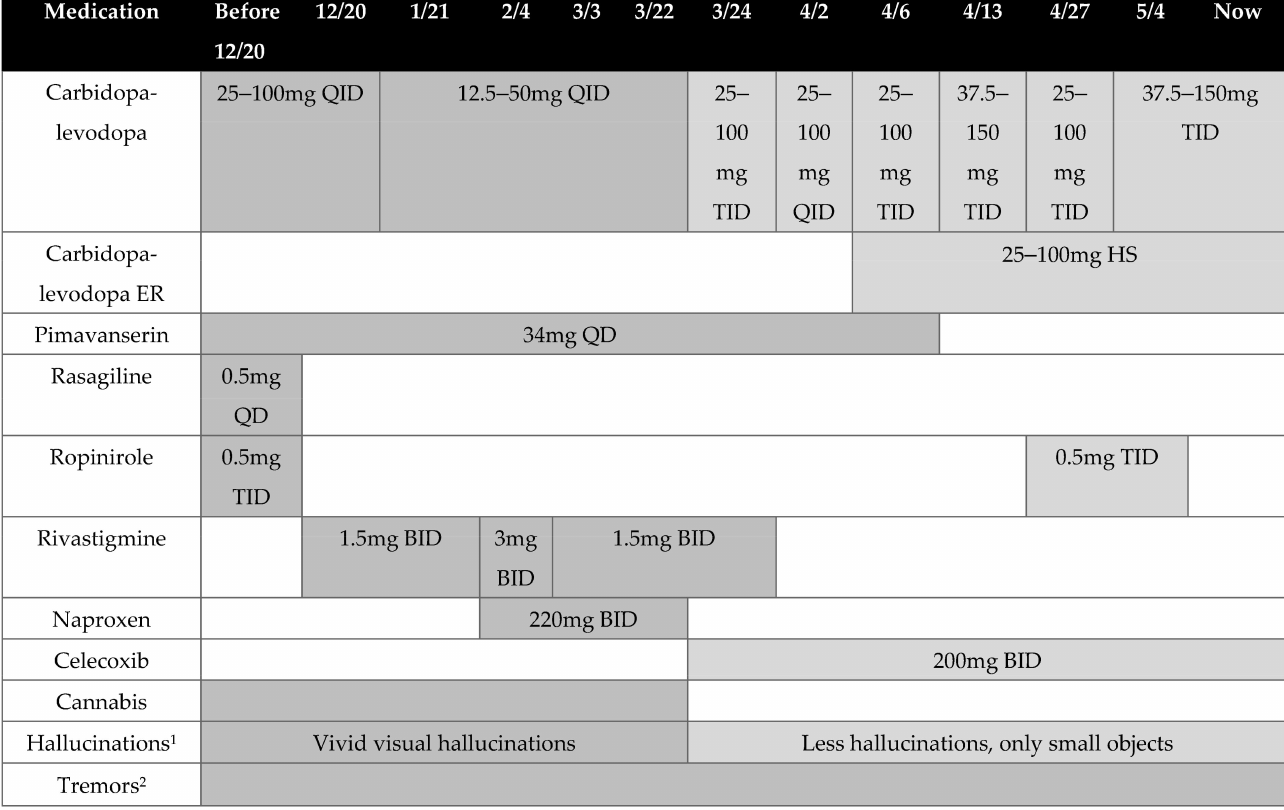
Figure 1. Drug and Symptom Change Timeline. 1 Shaded area in the chart represents when hallucinations were experienced by the patient. Shades of gray are associated with the presence of vivid or fewer hallucinations and which medications are administered at that time. 2 Period when tremor symptoms were experienced by the patient. Abbreviations: QD: once a